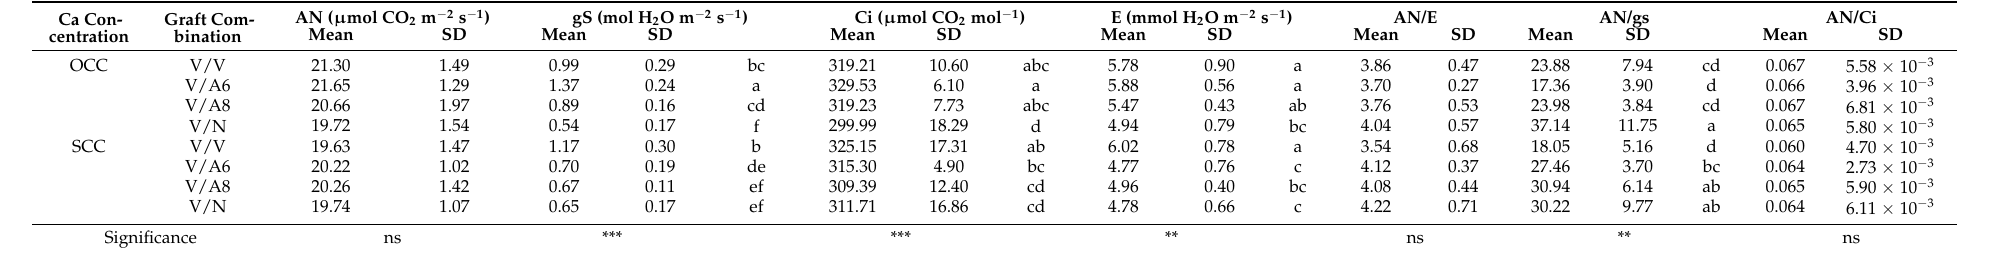
Table 1. Effects of calcium concentration and plant combinations on the net CO 2 assimilation rate (A N ), stomatal conductance (g S ), substomatal CO 2 concentration (C i ), transpiration rate (E), instantaneous water use efficiency (A N /E), intrinsic water use efficiency (A N /g S ) and instantaneous carboxylation efficiency (A N /C i ) of pepper leaves at the end of the experiment (98 DAT).